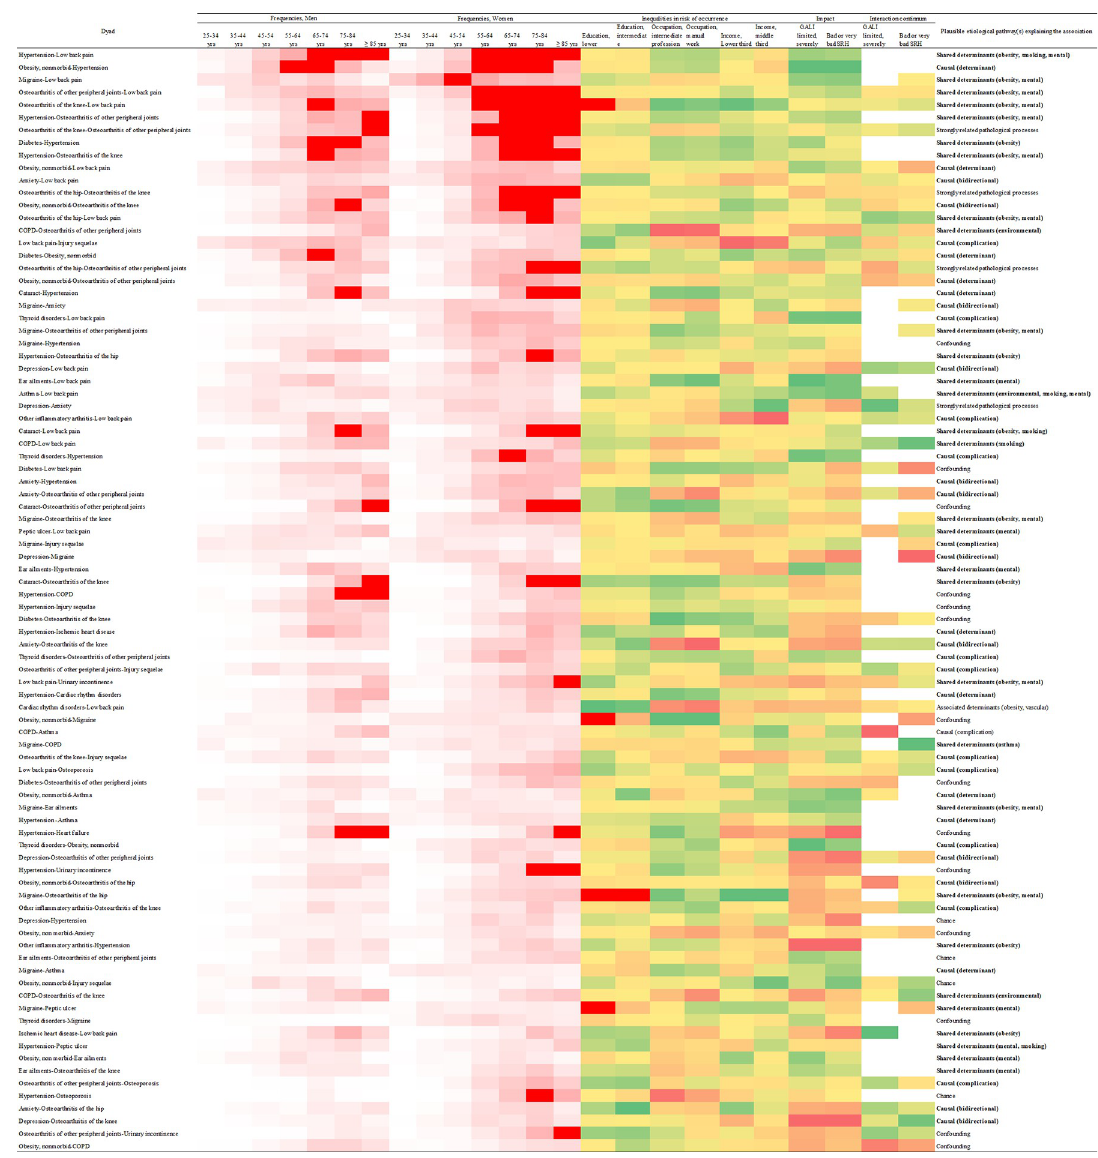
Fig 3. Summary characteristics of most frequent dyads (N = 88, � 0.75% in HSM survey): Frequencies across age and gender categories (white to red gradient), inequalities in risk of occurrence (education, occupation, income), impact and interaction for GALI and SRH (green to red gradient), and plausible etiological pathway(s) explaining the association [see Coste et al. 2021]